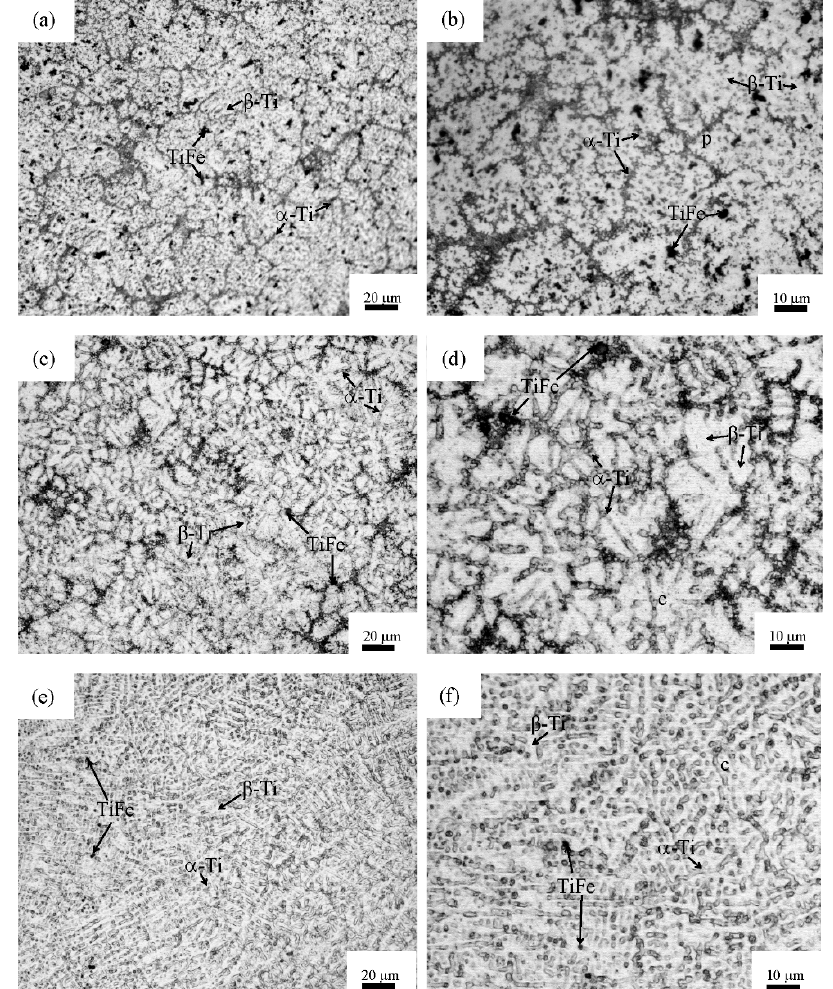
Figure 2. Microstructure of the ( a ) and ( b ) Ti 75 Fe 19 Sn 5 Mo 1 , ( c ) and ( d ) Ti 75 Fe 17 Sn 5 Mo 3 , ( e ), and ( f ) Ti 75 Fe 15 Sn 5 Mo 5